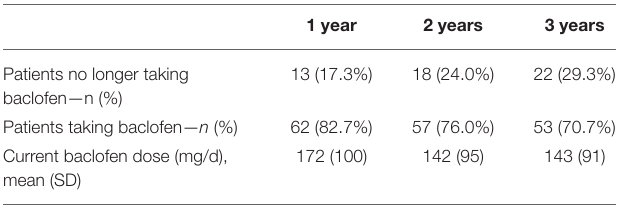
TABLE 2 | Baclofen dose during follow-up for patients with successful treatment at each yearly follow-up visit ( n =